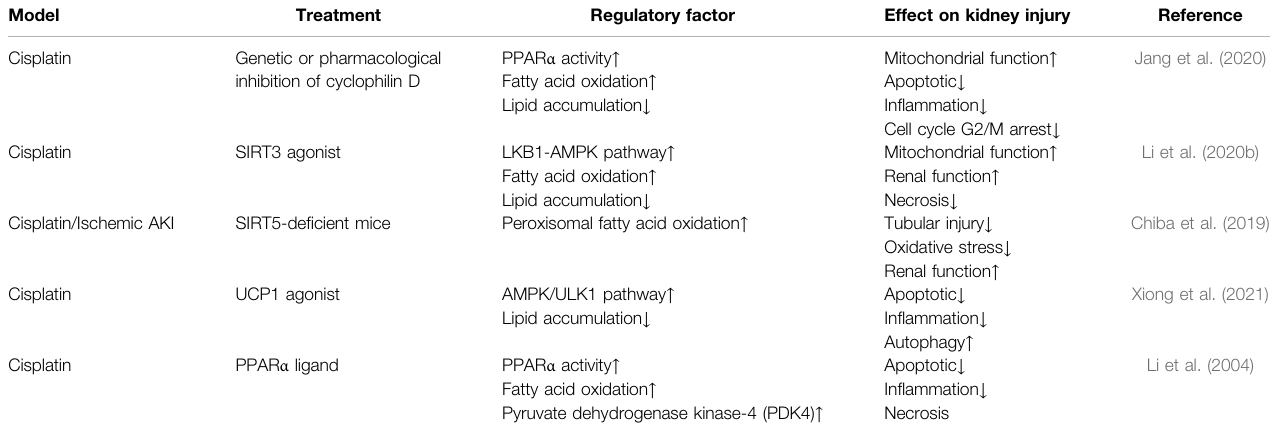
TABLE 1 | Intervene fatty acid β -oxidation in AKI.